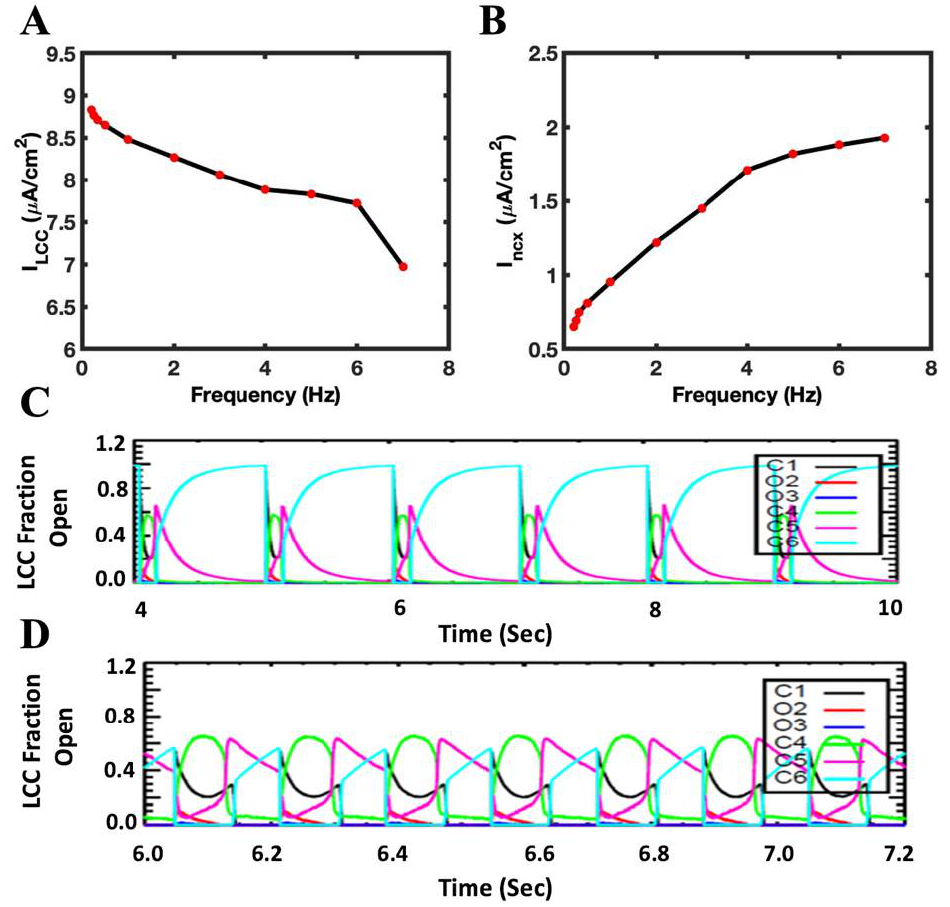
Figure 5. The surge in cytosolic Ca 2+ in rapid pacing frequency causes the influx of Ca 2+ to decrease because of Ca 2+ -dependent inactivation of L-type channels while extrusion of Ca 2+ increases. ( A ) I LCC amplitude decreases with the increase in the beating rate. ( B ) An increase in I ncx occurs when pacing frequency increases. ( C , D ) showing different opening, closing, or inactivation states of L-type channels in 1 Hz and 6 Hz pacing frequencies, respectively. C 4 (green) represents Ca 2+ -dependent inactivated CDI (state), and it is higher in 6 Hz than 1 HZ. C 1 (black) & C 6 (cyan) closed states, O 2 (red) & O 3 (blue) open states, and C 5 (magenta) VDI state.